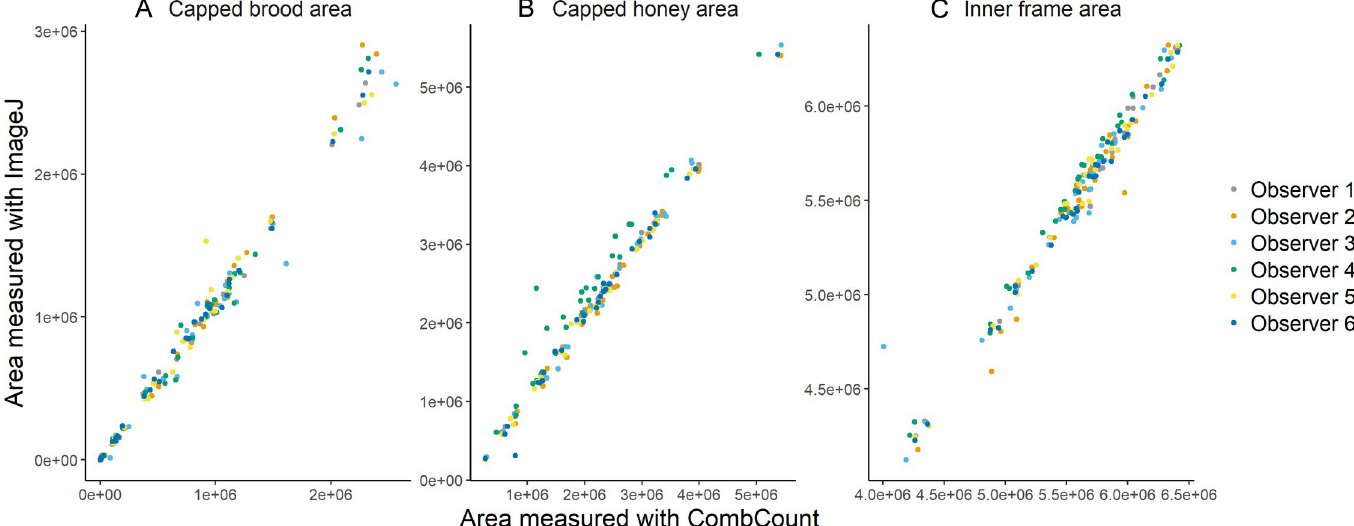
Fig 3. Correlations between the measurements of (A) capped brood, (B) capped honey, and (C) inner frame area with ImageJ and Python from 6 different observers.